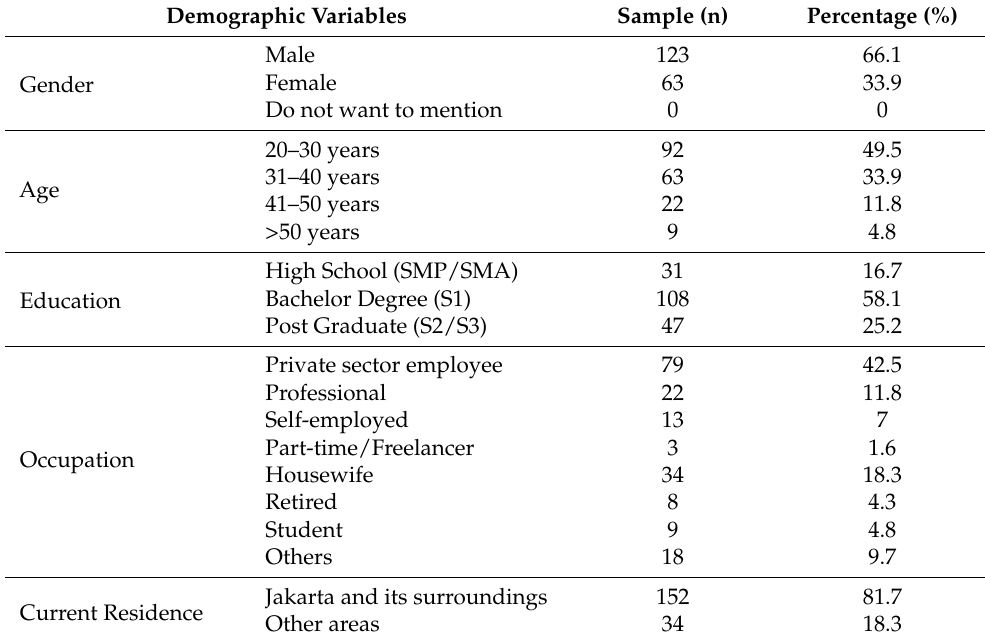
Table 2. Respondent demographic